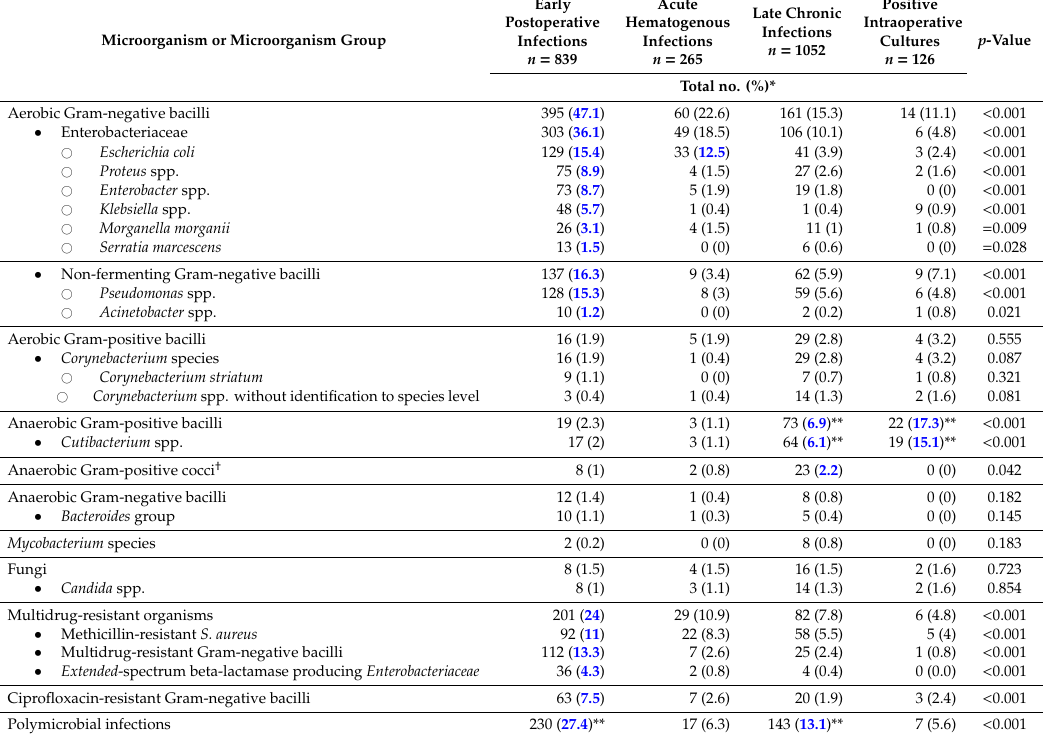
* Percentages marked in bolded blue are the highest statistically significant percentages in that row. Two percentages marked in bolded blue in the same row with no other marks, refer to the highest percentages (both are significantly higher than the other two percentages), but with no statistically significant differences between them. ** The two highest percentages in that row but with statistically significant differences between them. † Finegoldia magna 5, Parvimonas micra 5, Peptostreptococcus anaerobius 3, Peptococcus niger 4, Peptostreptococcus not identified to species level